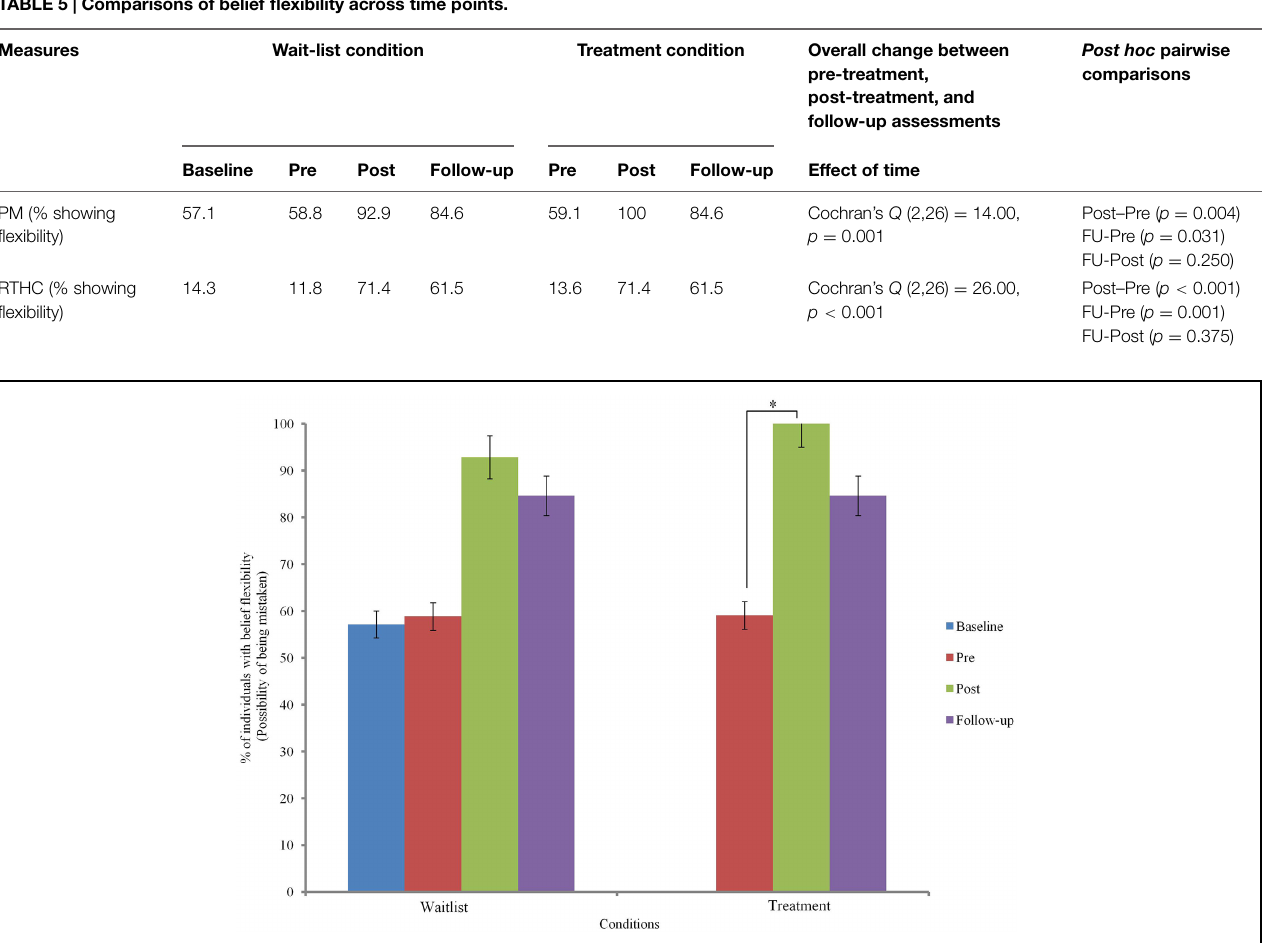
FIGURE 3 | Possibility of being mistaken (PM) across groups. ∗ indicates p <